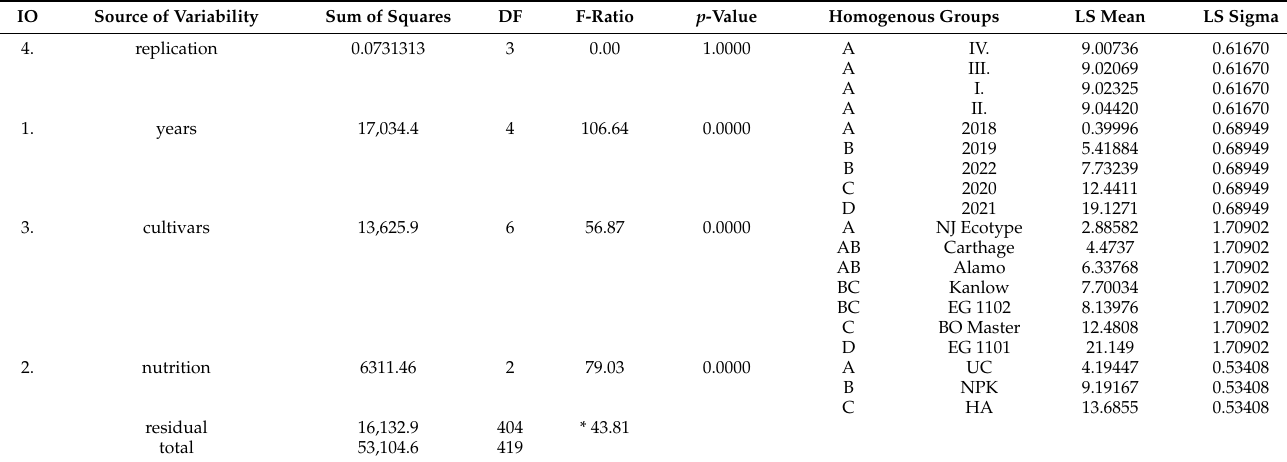
Table 6. MANOVA of the yield data. Table 5. Crop harvest dates.